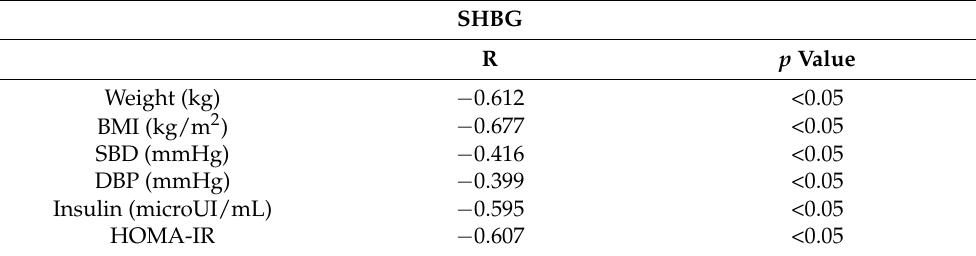
Table 2. Univariate correlations between SHBG and clinical and biochemical